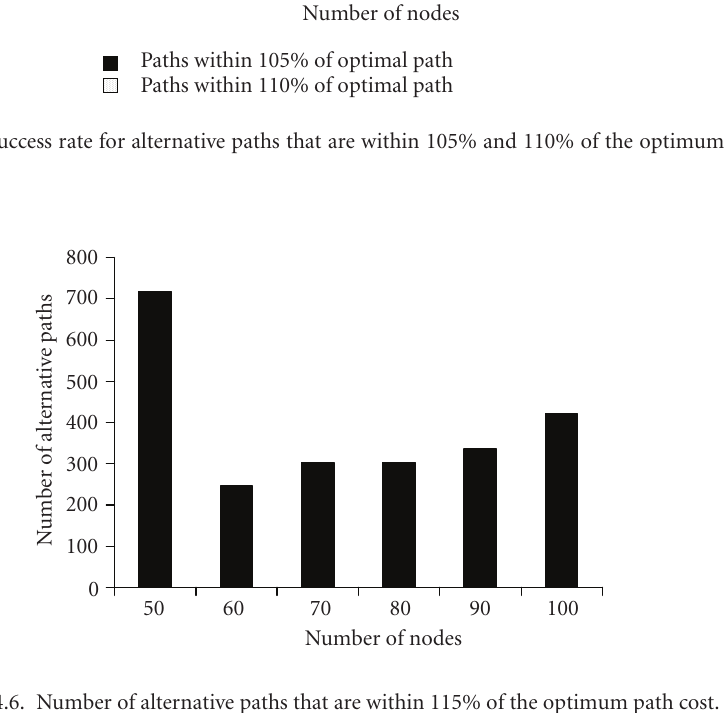
Figure 4.6 . Number of alternative paths that are within 115% of the optimum path